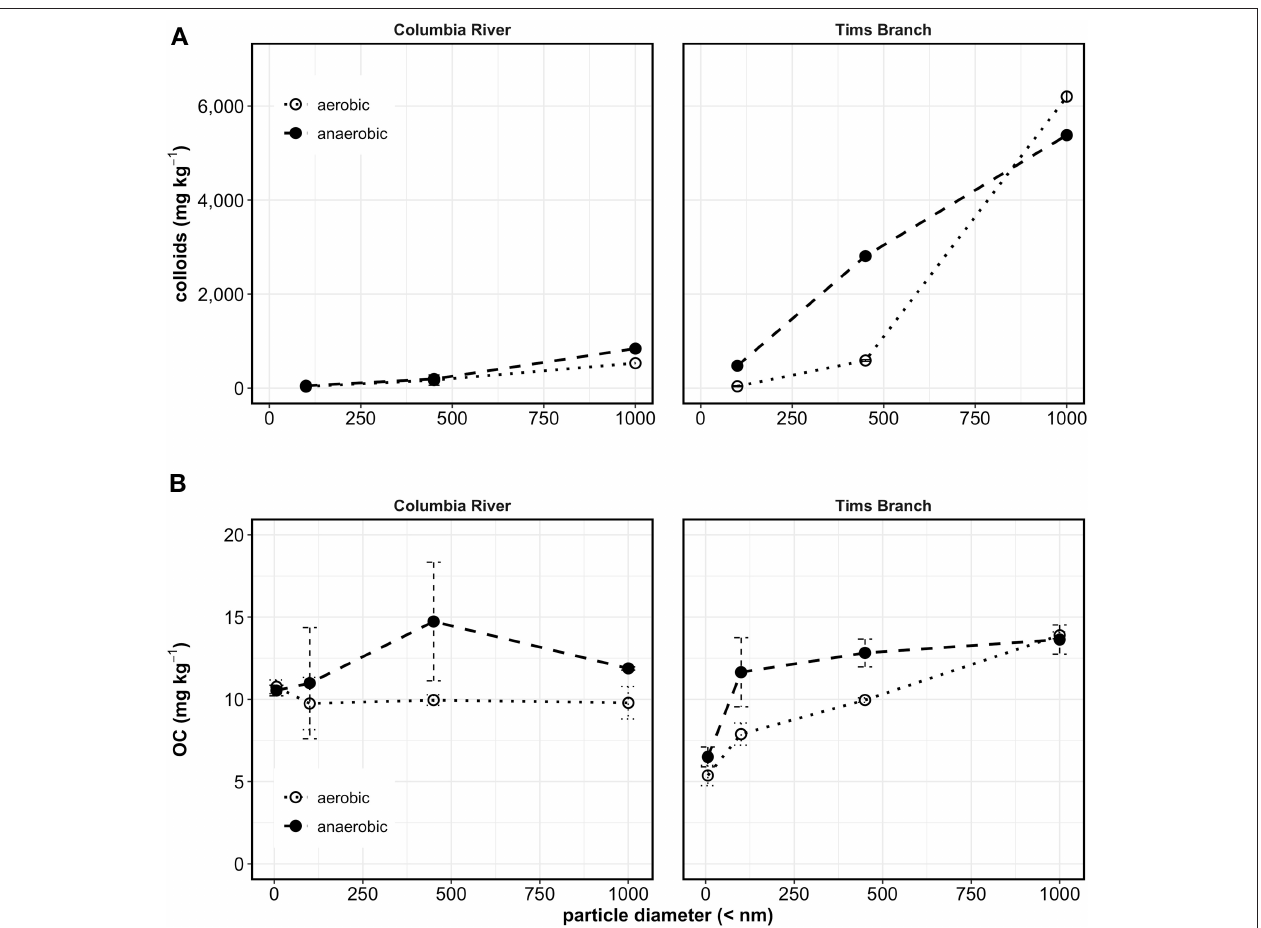
FIGURE 1 | Water dispersible colloid mass released per mass of sediment (A) , and OC mass per mass sediment (B) fractionated by centrifugation to select colloid diameters < 1,000, < 450, < 100, (and < 6nm for OC) from batch water extractions of Columbia River sediments, and Tims Branch sediments. Error bars represent one standard deviation from measurement replicates; lines between points are to help with visualization and do not represent a regression model.